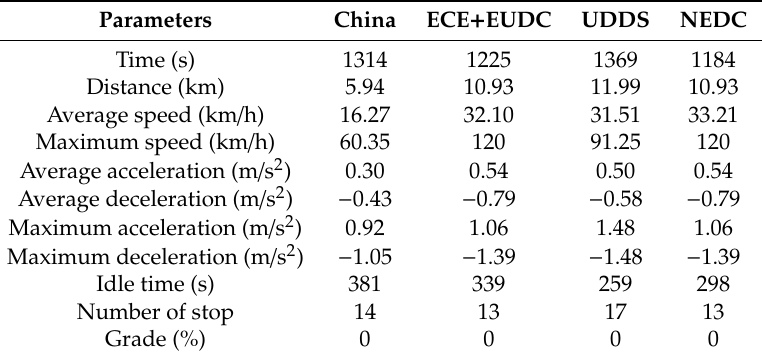
Table 4. Parameters of driving cycle.